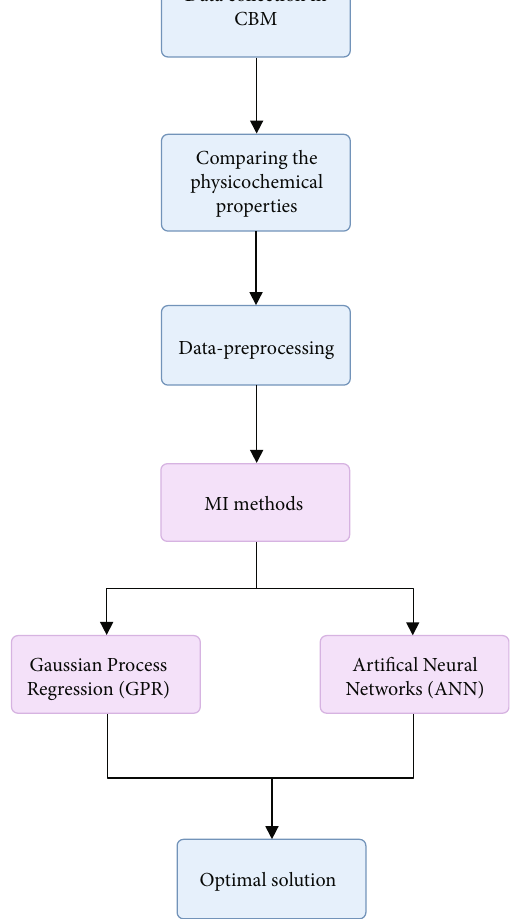
Figure 1: Architecture of the proposed